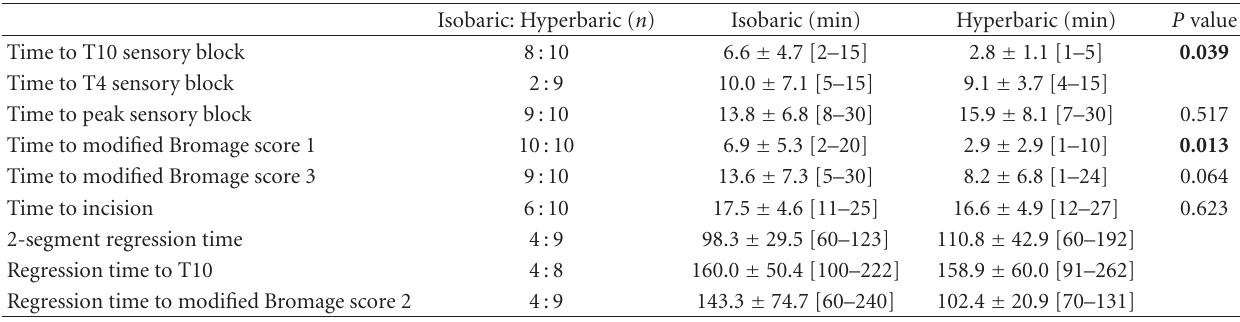
Table 2: Characteristics of intrathecal blocks with isobaric or hyperbaric levobupivacaine in patients undergoing gynecologic surgery. Values are number of patients in each group, or minutes in mean ± SD